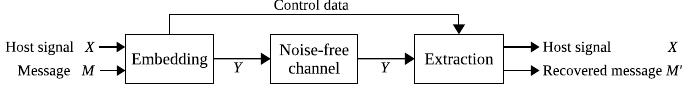
Figure 2. General fragile reversible watermarking scheme.